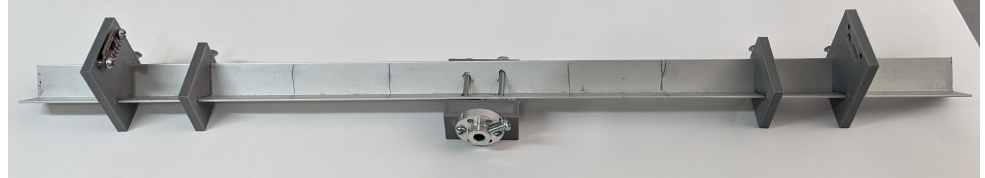
Figure 3. Final assembly of 3D-printed parts (scaffolding for the distance sensor and stopper) on the aluminum